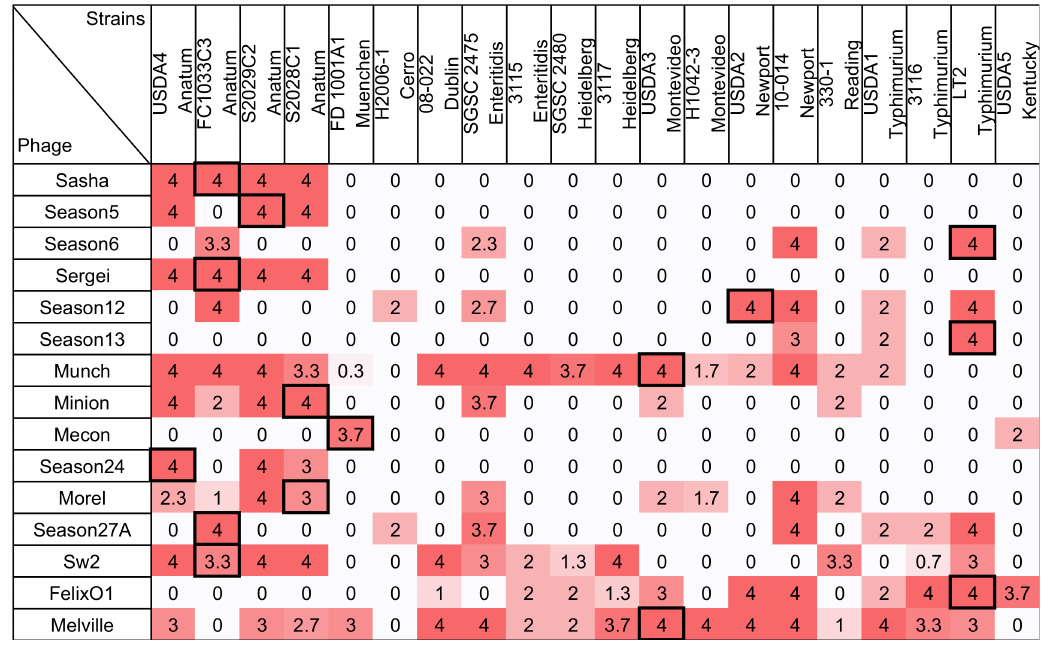
Figure 2. The host range of 15 Salmonella phages against 20 Salmonella strains were measured by spotting on soft agar overlays. Phages were plated at the routine test dilution (RTD and determined as the first tenfold serial dilution of phage lysate that formed countable plaques on lawns of its own host) and 100 × the RTD. Phage were tested and scored on the following criteria: phage forming >50% of the number of plaques formed on its host strain at its RTD = 4; phage forming 5% to 50% of the number of plaques formed on its host strain at its RTD = 3; phage forming a zone of confluent lysis but no individual plaques at 100 × RTD = 2; phage forming individual plaques at 100 × RTD = 1; and no plaque or clearing formation at either dilution = 0. The scores from three replicate experiments were averaged. To aid the reader, cells are shaded with stronger color intensity indicating a greater score. Boxed cells indicate the initial isolation and propagation host of the phage. For clarity, all values are displayed to one significant figure unless a non-zero value is present at the first decimal